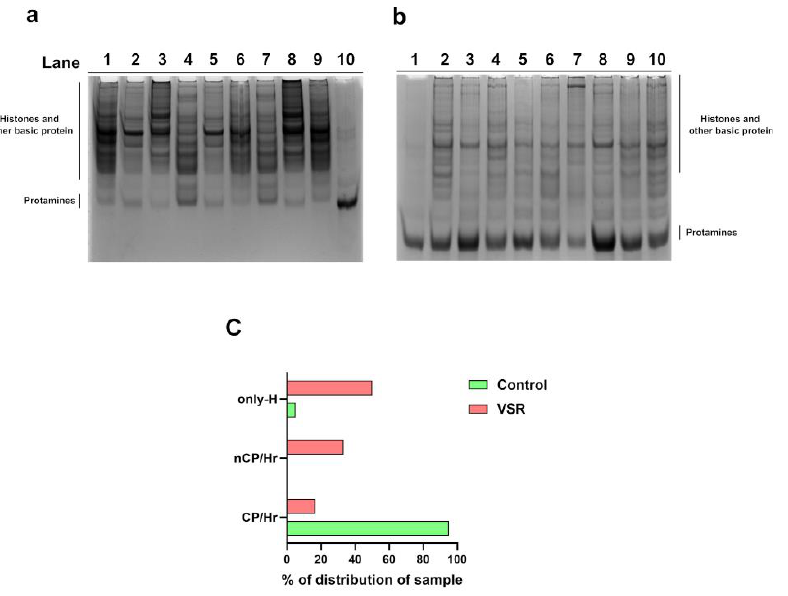
Figure 6. SNBP content as characterized by AU-PAGE displayed three different expression patterns. A normal canonical protamine/histone ratio (CP/Hr) was seen mainly in control group samples (( a ), lane 10; ( b ), lane 1), while VSR samples more commonly displayed a histone-only ratio (( a ), lanes 1–9) or a non-canonical protamine/histone ratio (( b ), lanes 2–10). ( c ) Percentage distribution of protamines/histones ratios found in spermatozoa. In green, control group, in red, VSR group. CP/Hr: canonical protamine/histones ratio; nCP/Hr: non-canonical protamine/histones ratio; only-H: only histones.